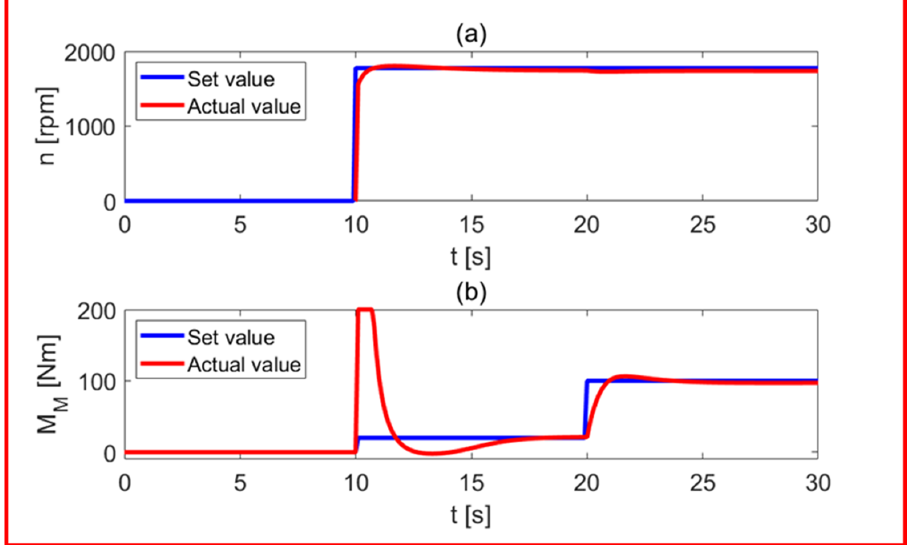
Figure 16. Rotational speed ( a ) and electromagnetic torque of the motor ( b ) using the Field Oriented Control (FOC) method.